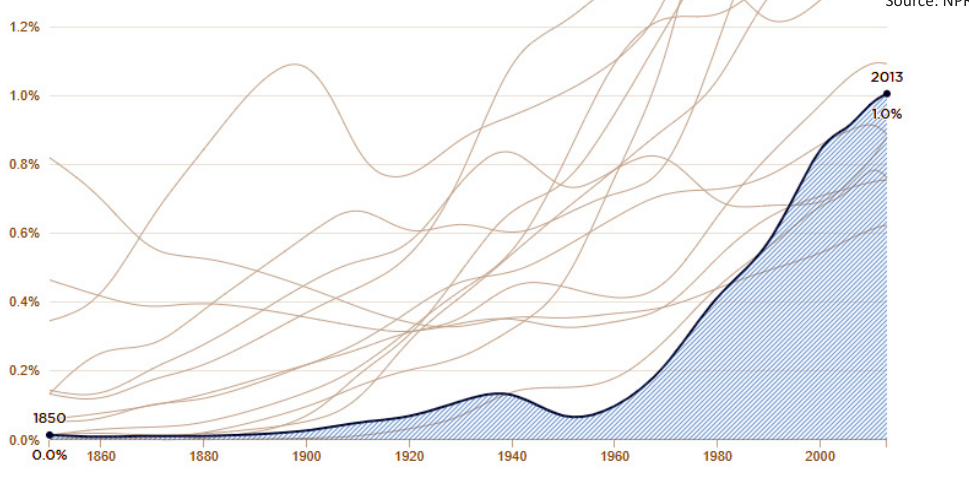
Figure 4. Demand for